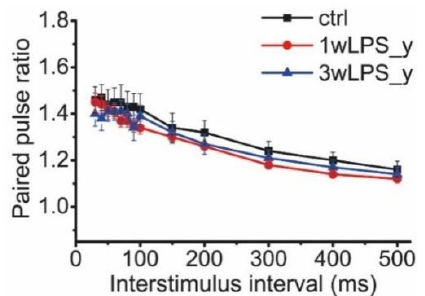
Figure 3. The PPRs of the fEPSPs evoked at different interstimulus intervals in the range from 30 to 500 ms in the control and experimental groups. Repeated measures ANOVA: F 24,336 = 1.23; p = 0.22. Ctrl (n = 9), 1wLPS_y (n = 12), 3wLPS_y (n = 10).